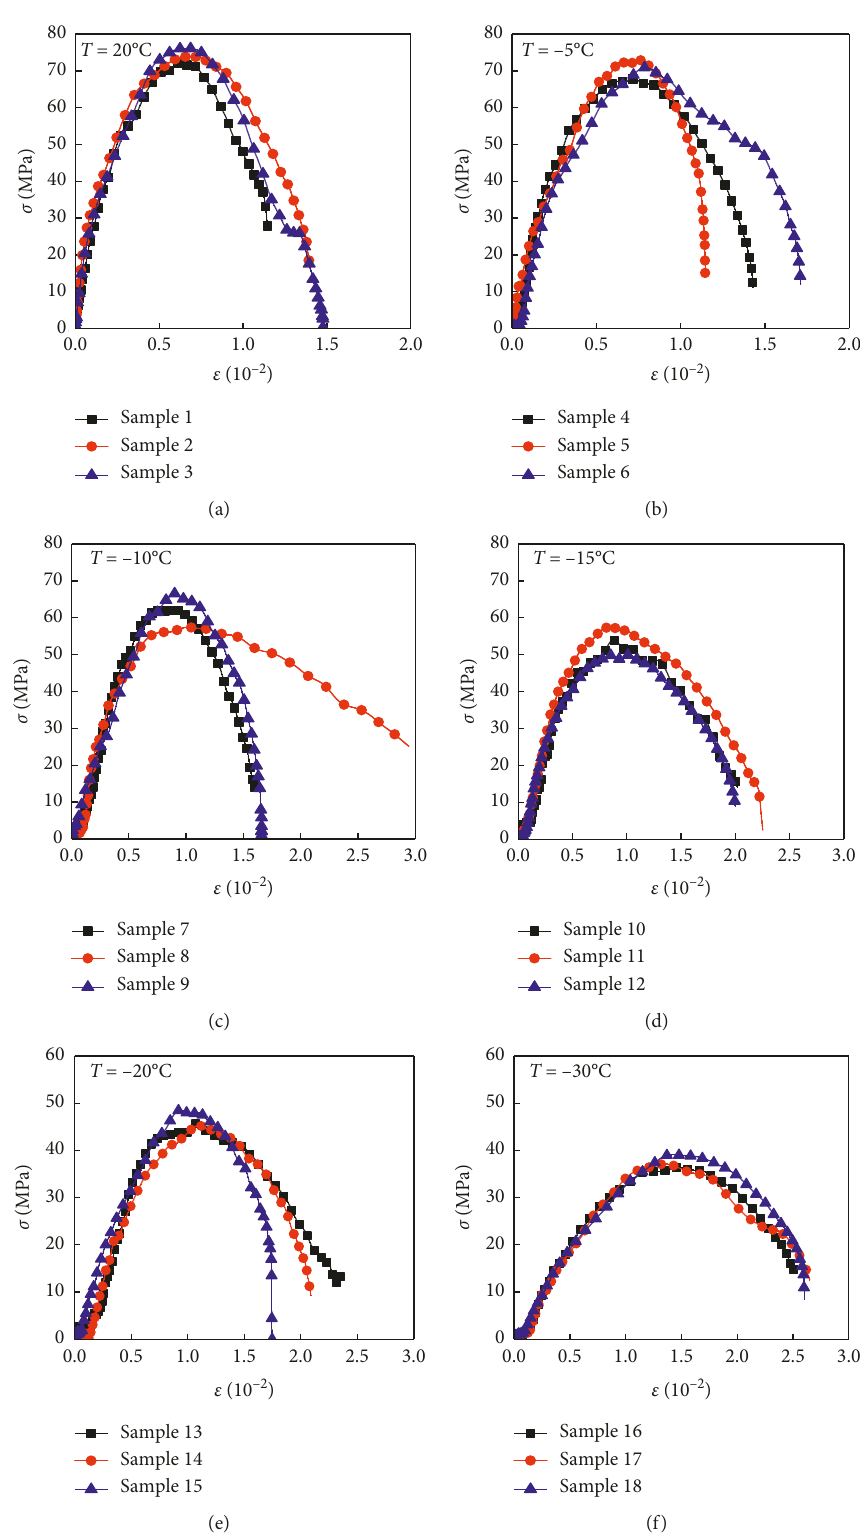
Figure 9: Dynamic stress-strain curves under various F-T